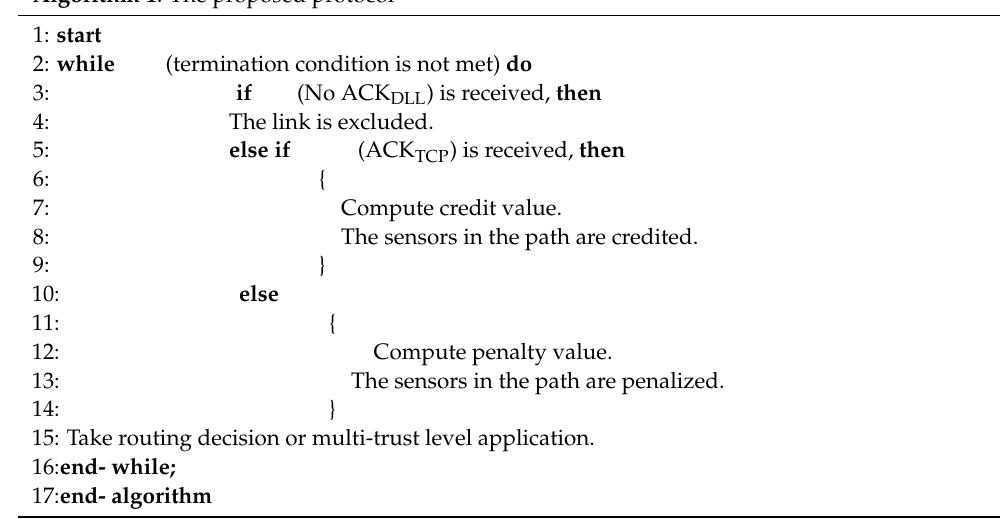
Algorithm 1 : The proposed